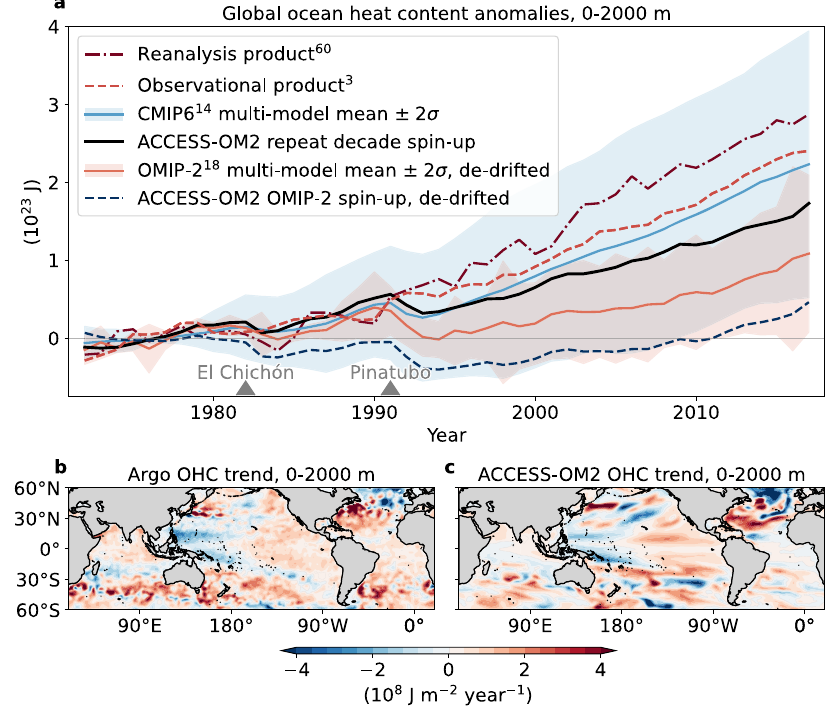
Fig.2|Recentglobaloceanheatcontent(OHC)anomaliesinobservationsand hindcastmodelsimulations.a Globaloceanheatcontentanomalies(10 23 J)inthe upper 2000 m from ocean reanalysis 60 , observations 3 , 25 fully coupled historical CMIP6 model runs 14 (including their multi-model mean and 2 σ variance), the full forcing ocean-sea ice simulation (ACCESS-OM2 repeat decade spin-up, where all atmospheric forcing fi elds evolve over time), 11 de-drifted OMIP-2 ocean-sea ice model simulations 18 (including their multi-model mean, and 2 σ variance) and the